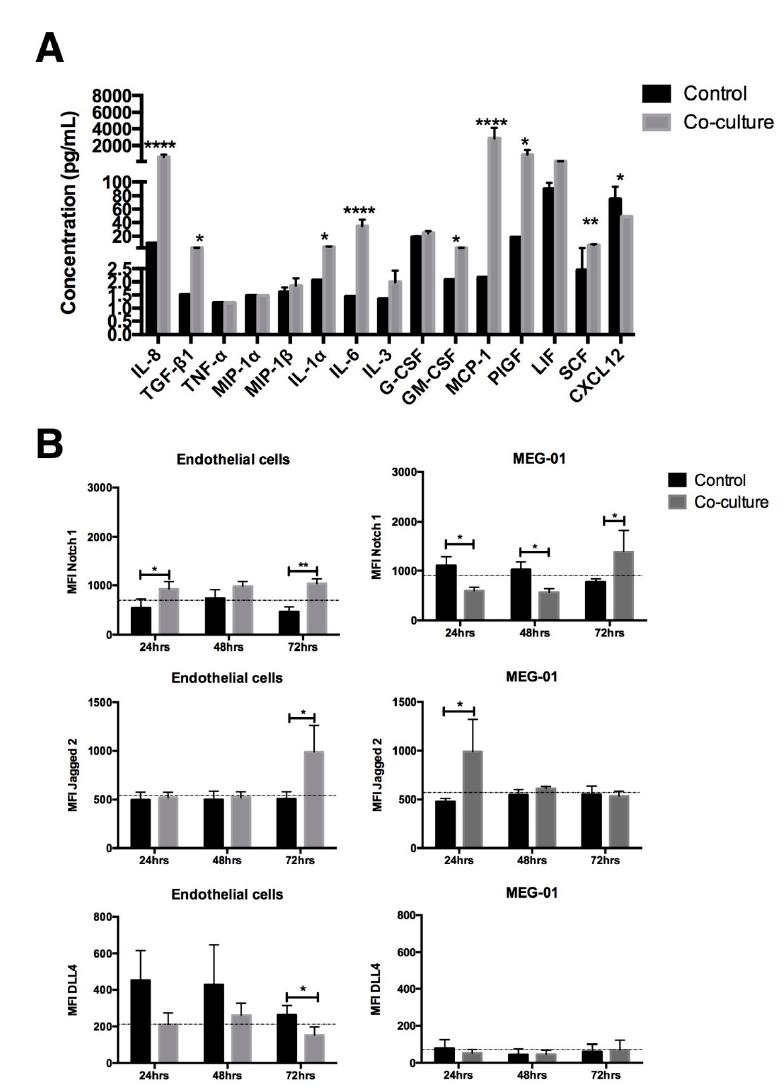
Figure 4. Cytokine profile and notch expression after co-culture with EC: ( A ) cytokine concentration (pg/mL) in co-culture supernatants was evaluated (by milliplex immunoassay) after three days of co- culture. ( B ) Notch1, Jagged-2 and DLL4 expression in endothelial cells and MEG-01 cell line after 24, 48 and 72 h of co-culture were analyzed by flow cytometry. The data are expressed as mean ± SEM or only the mean of 3 independent experiments in triplicate; * p ≤ 0.05, ** p ≤ 0.005, **** p ≤